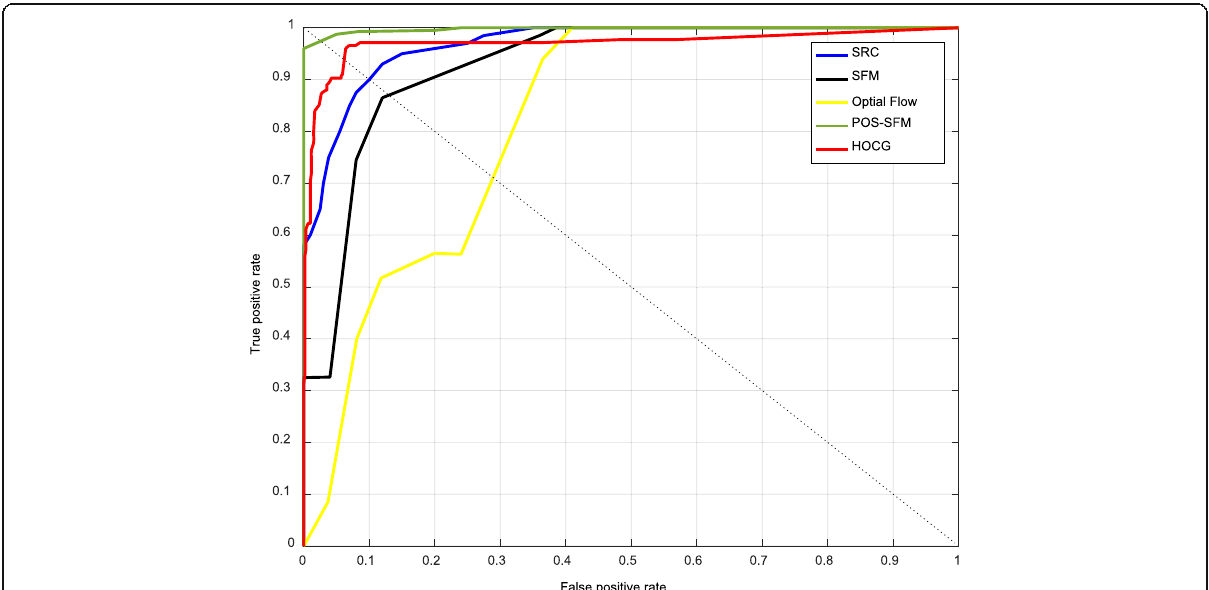
Fig. 8 Quantitative comparison of the detection results from the UMN dataset using ROC curves